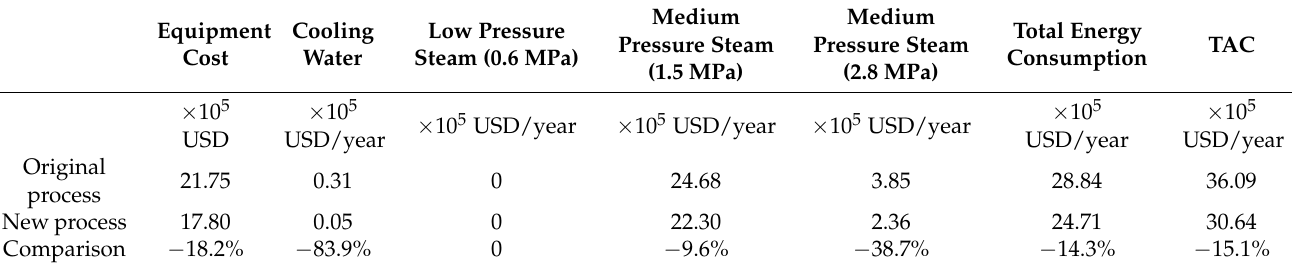
Table 7. Comparison of heat integration results with the original